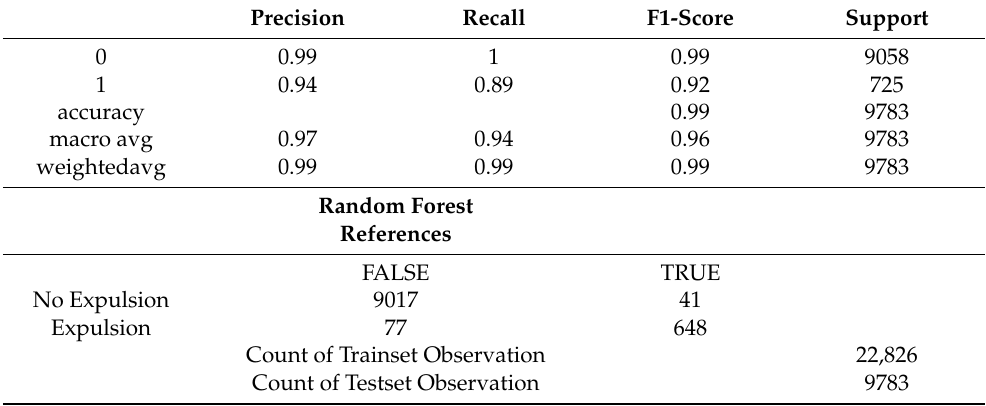
Table 13. Confusion matrix for random